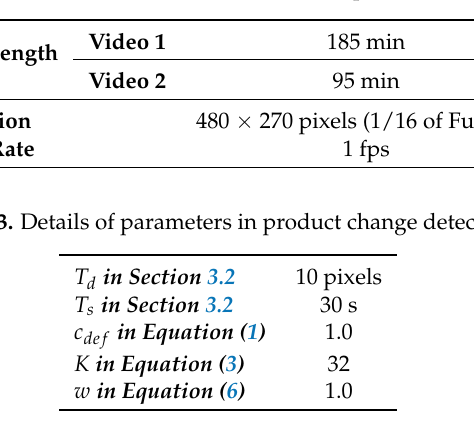
Table 2. Details of videos used in experiments.